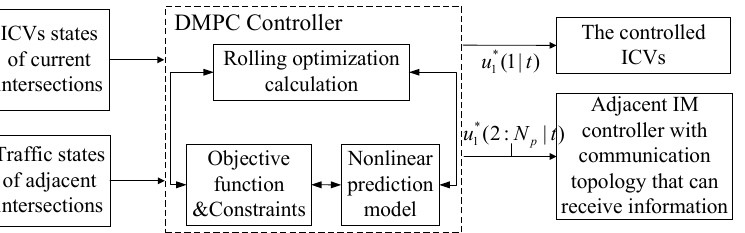
Figure 3. Control schematic diagram of IM controller based on DMPC method.